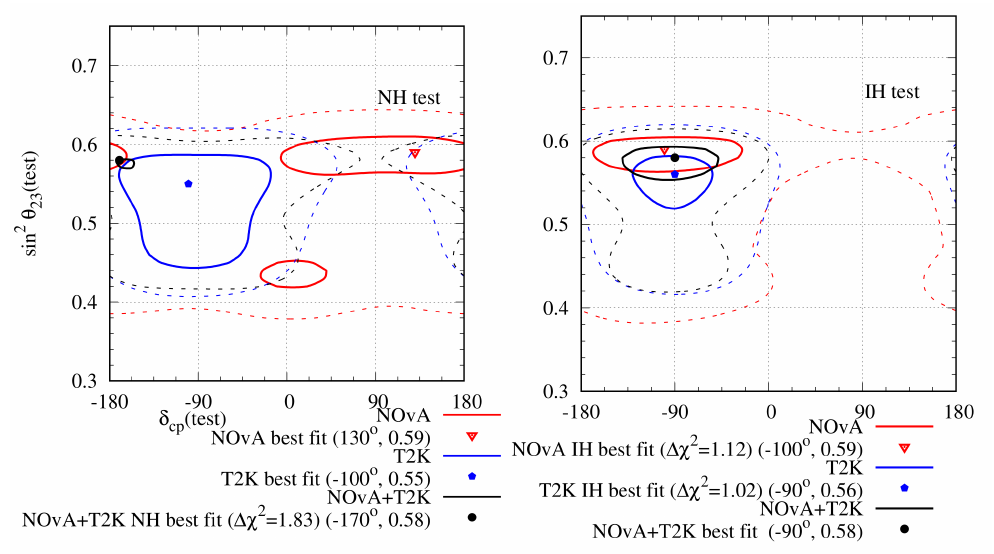
Figure 6. Allowed region in the sin 2 θ 23 − δ CP plane after analysing NO ν A and T2K complete data sets. The left ( right ) panel represents the test hierarchy to be NH (IH). The red (blue) lines indicate the results for NO ν A (T2K) and the black line indicates the combined analysis of both. The solid (dashed) lines indicate the 1 σ (3 σ )-allowed regions. The minimum χ 2 for NO ν A (T2K) with 50 (88) bins is 48.65 (95.85) and it occurs at NH. For the combined analysis, the minimum χ 2 with 138 bins is 147.14, which occurs for